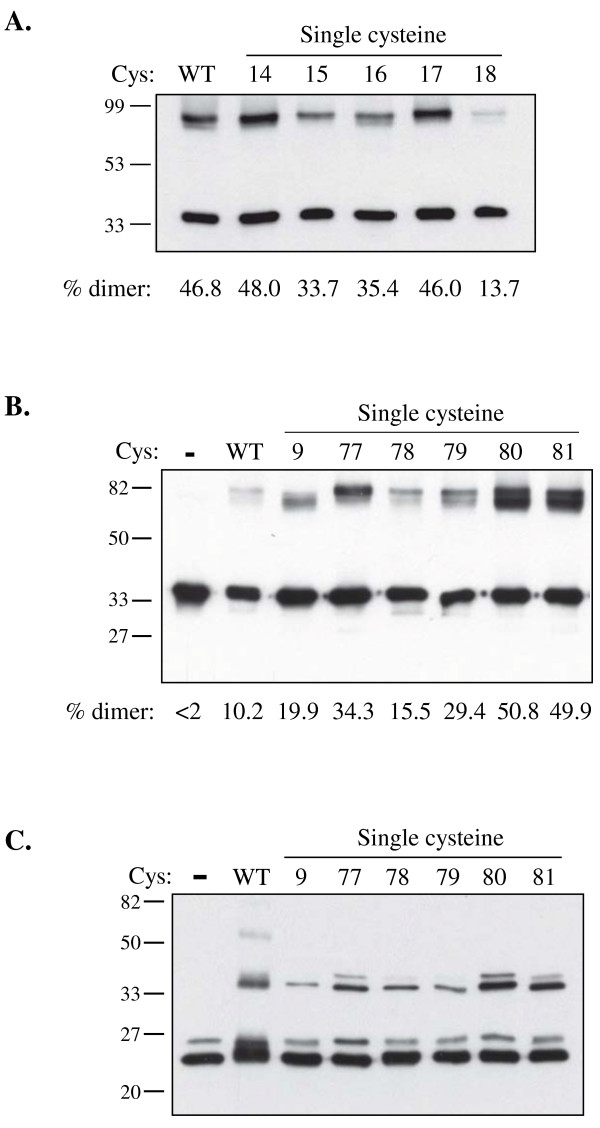
Cross-linking of single-cysteine mutants of CD9 protein. GFP fusions of CD9-TM(1+2) protein (panels A and B) or untagged full-length CD9 (panel C), and containing wild-type cysteines (Cys9,78,79), a single cysteine at positions indicated, or no cysteines (all replaced by Ser) were transiently expressed in human RD cells and cross-linked using CuP. Cell lysates were analyzed by Western blotting for GFP (panels A and B) or CD9 (panel C). % dimer is the fraction of dimer in total protein material (monomer + dimer), based on densitometry measurements of respective bands.